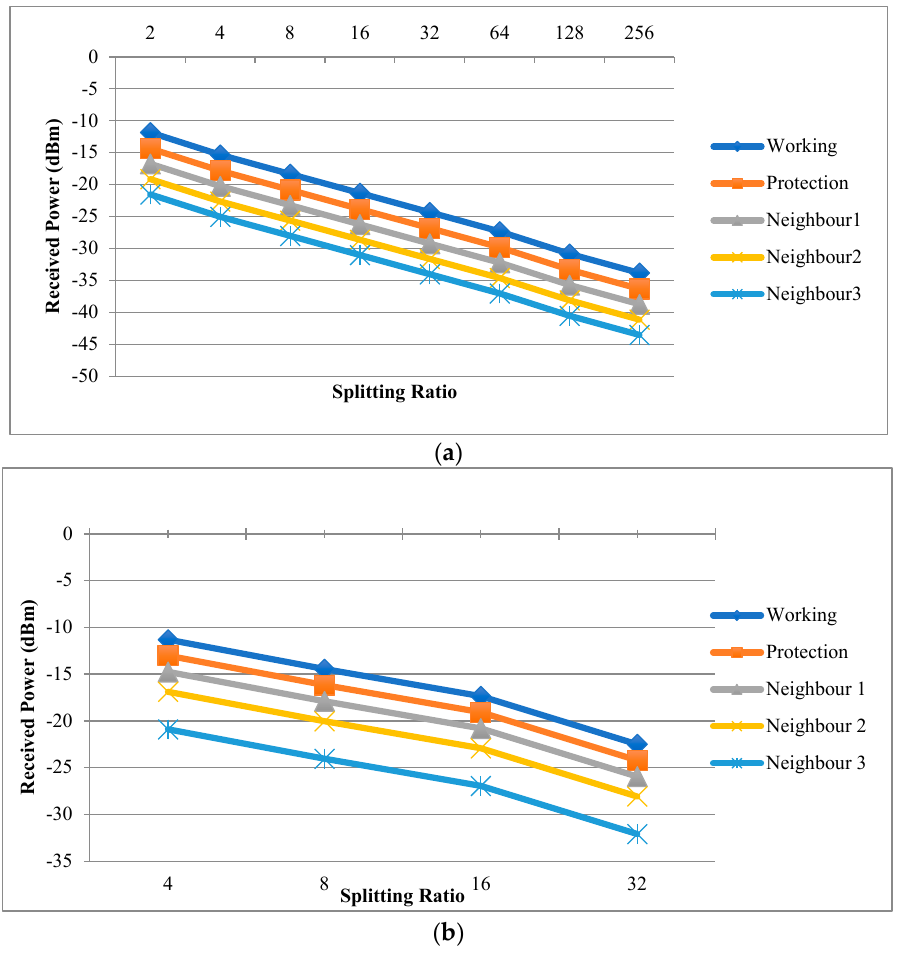
Figure 25. Received optical power with different split ratio: ( a ) simulation, ( b ) experimental.